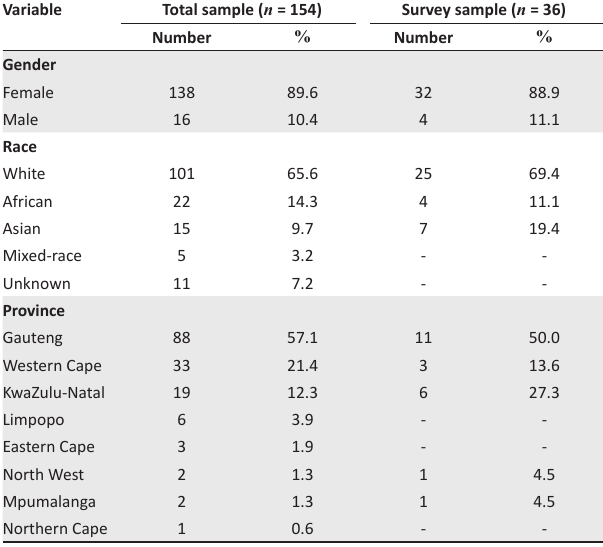
TABLE 1: Biographical composition of the UNISA student psychometrists in terms of gender, race and geographical area.